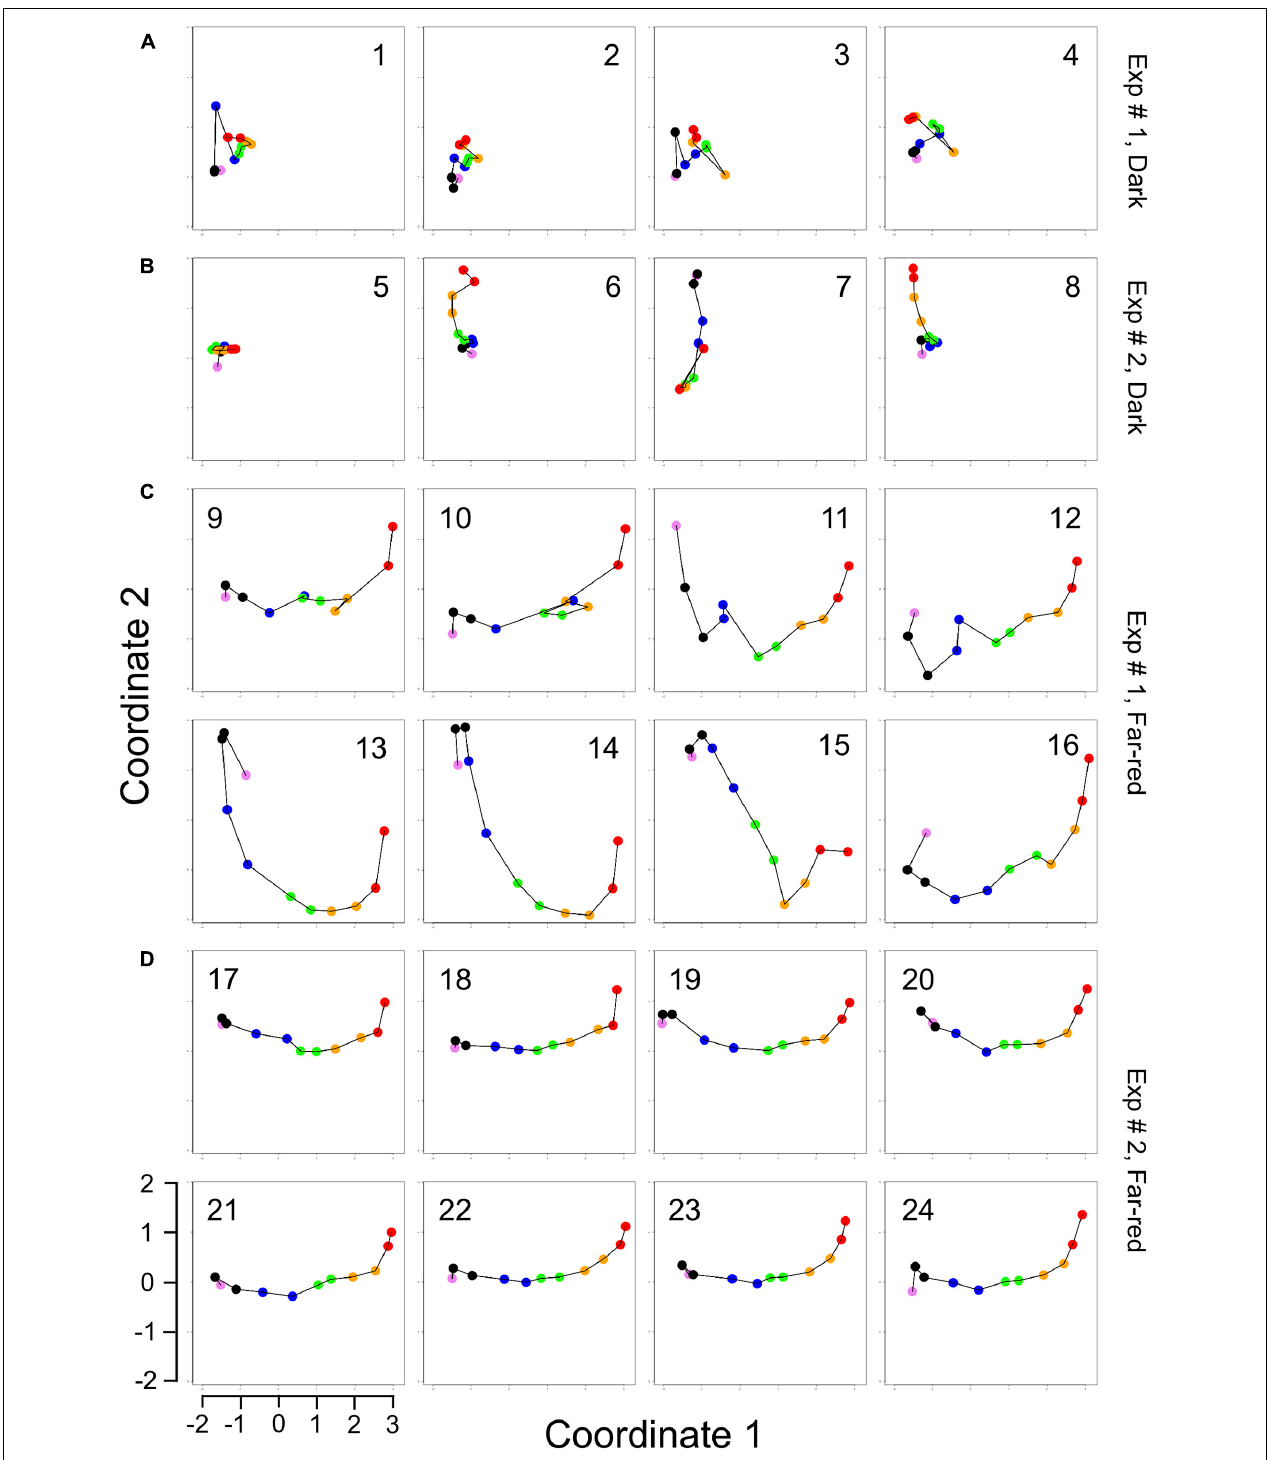
FIGURE 3 | Single cell trajectories of gene expression displayed after multidimensional scaling (MDS) of the expression patterns. Panels (A,B) show the trajectories of unstimulated cells of experiment #1 and experiment # 2, respectively. Panels (C,D) show the trajectories of far-red stimulated cells of the two experiments. Each data point represents the gene expression pattern of a cell at a given time point at 1 h time intervals. The start position (0 h) of each trajectory is encoded in pink and the endpoint (10 h) in red. The number displayed in each subpanel refers to the ID number of the plasmodial cell (P1 to P24) as listed in Table 2 . All cells of the dark controls did not sporulate while all far-red irradiated cells sporulated. All plots are displayed at the same scale.